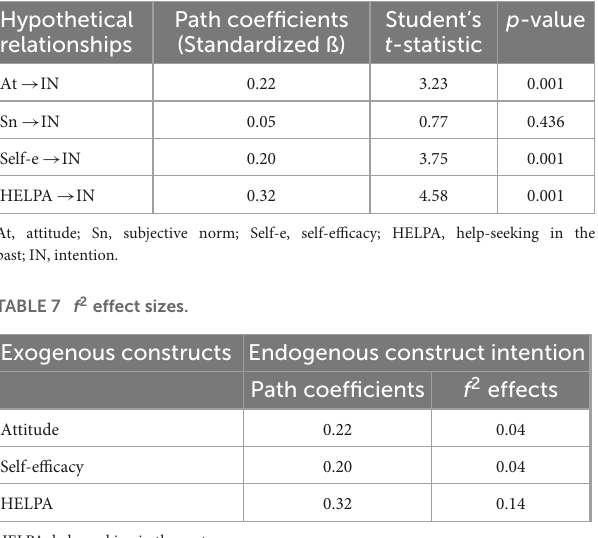
TABLE 9 Correlations of Pearson IH-RHAC scales with barrier